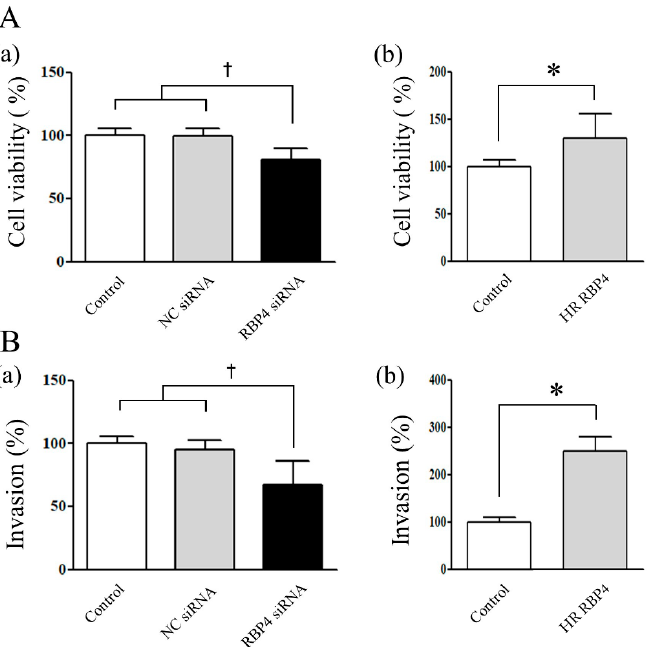
Figure 3. Cellular viability ( A ) and invasiveness ( B ) of endometrial stromal cells following treat- ment with the vehicle, transfection with the negative control siRNA or RBP4 siRNA (a), or